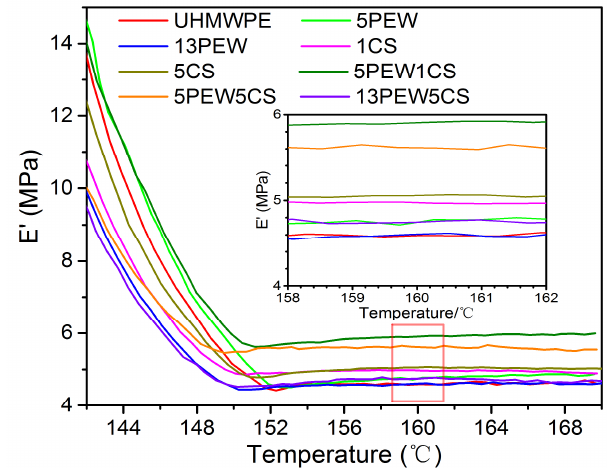
Table 3. E′, M e , and υ e values of UHMWPE with different contents of PEW and CS.